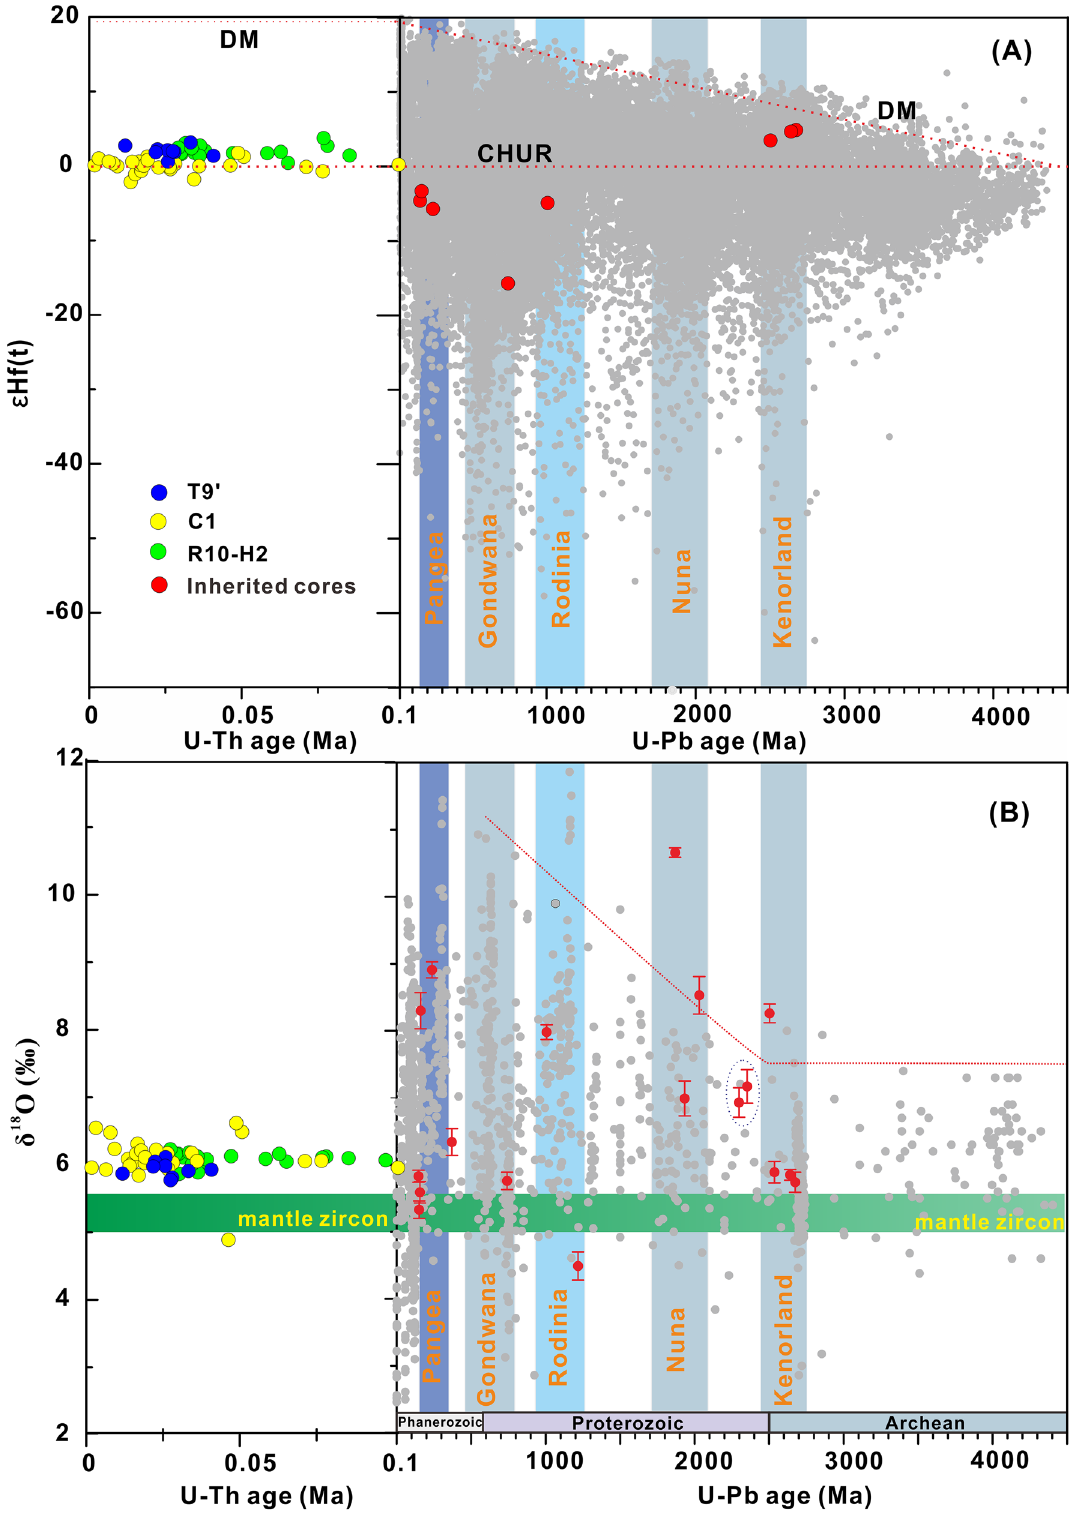
Figure 2. Plots of ( a ) εHf (t) and ( b ) δ 18 O versus time for the Light-CL zircons and their inherited cores. The light grey dots represent global zircon εHf (t) (Roberts and Spencer 43 ,) and δ 18 O data (Spencer et al. 44 ). The vertical bars represent supercontinent amalgamation events 35,36,44 . The dotted ellipse denotes line is mark of the inherited zircons with ages outside of the ranges of the supercontinent amalgamation